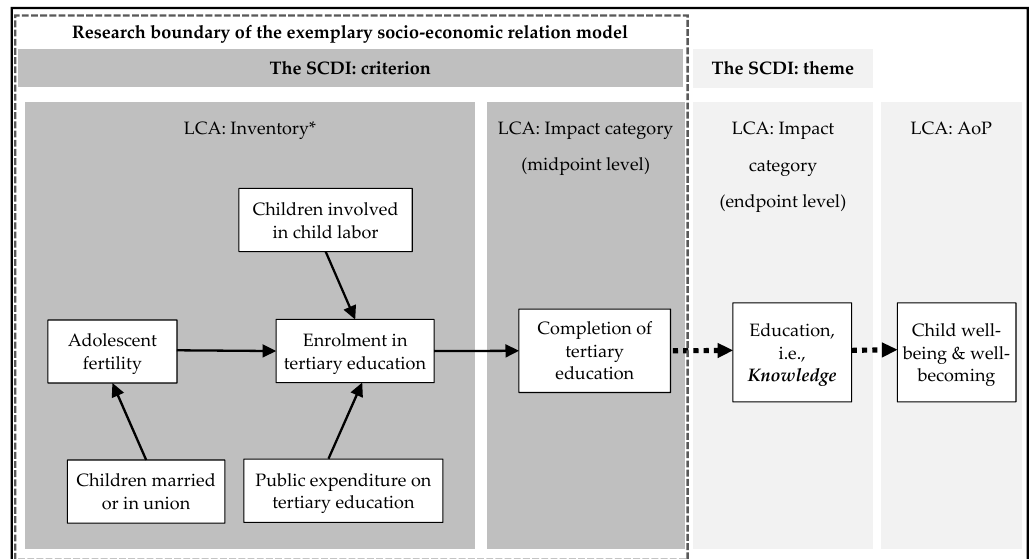
Figure 4. A preliminary social impact pathway addressing the criterion completion of tertiary education and its relation to the impact assessment of LCA and the SCDI framework. * Inventory denotes the selected criteria that may relate to the presumed midpoint impact